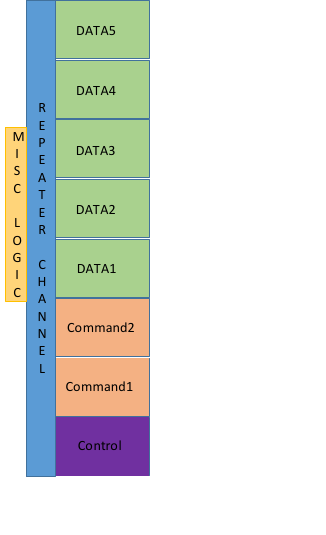
Table5: Distance getting calculated automatically between each partitions in floorplan